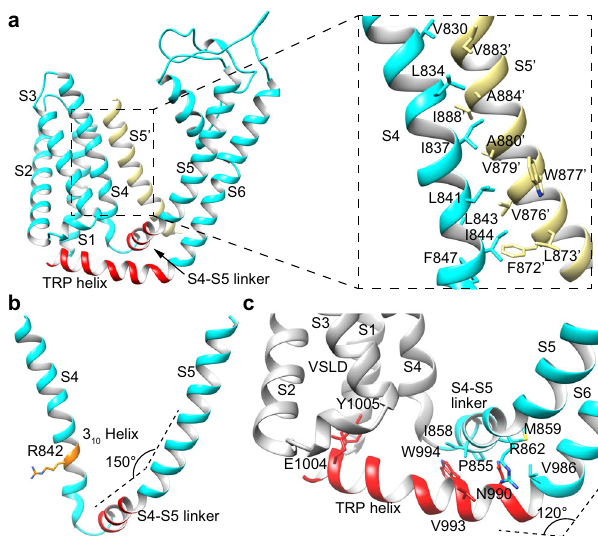
Fig. 4 Interactions between VSLD and the pore domain in MmTRPM8 LMNG-ligand-free . a Hydrophobic interactions between S4 (cyan) and S5 from the adjacent subunit (yellow). b The structure of S4 and S4-S5 linker. The 3 10 helix in S4 is highlighted by orange color. c Interactions between TRP helix and S4-S5 linker. The polar residues Glu1004 and Tyr1005 in the C-terminal end of TRP helix point to the cytosolic-facing cavity of wild type (WT) MmTRPM8 with an EC 50 value of